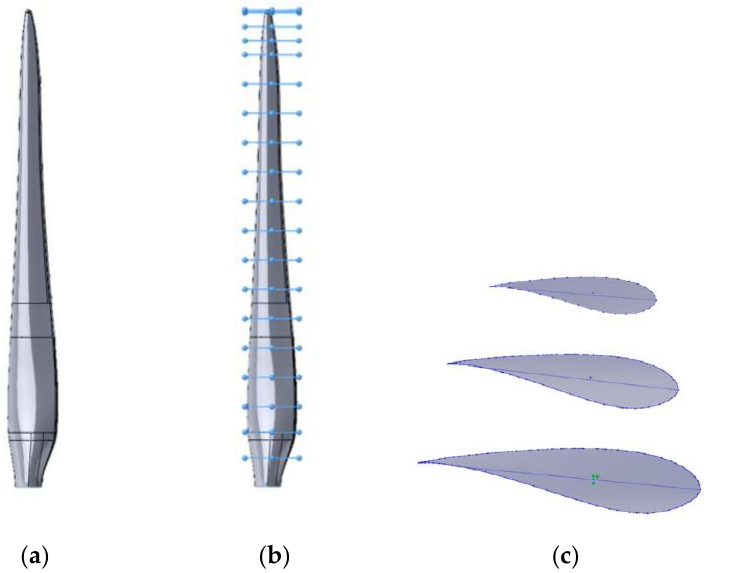
Figure 2. ( a ) Blade models acquired through scanning; ( b ) sectional segmentation for airfoil extraction; ( c ) blade airfoil for each section acquired.